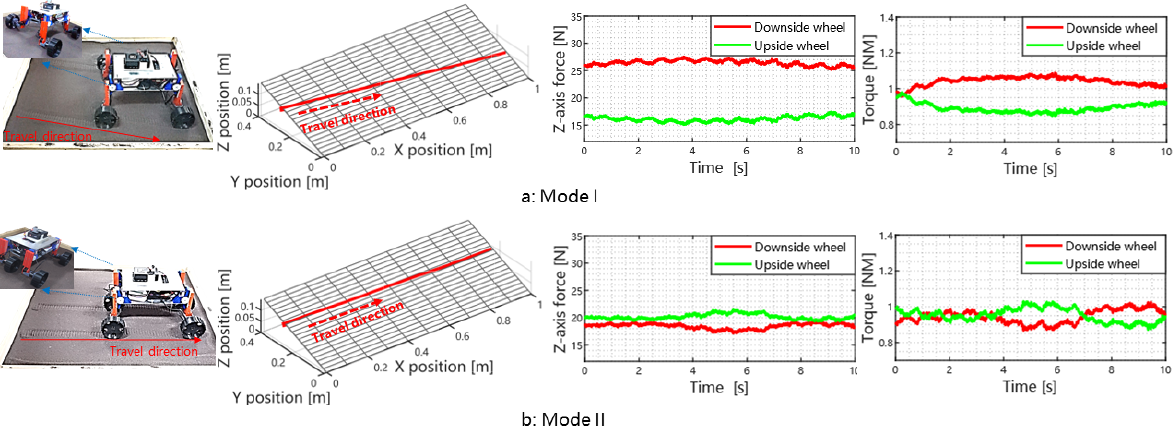
Figure 7. The rover trajectory and force/torque data were collected in the traversing task on a 20 ◦ slope. For sub-figure ( a ), the rover state is the mode I, While mode II is selected for the rover in sub-figure ( b ). The first column shows the experimental scenarios and the motion modes of ROMA- Sloper. The second column shows the trajectory of ROMA-Sloper after traversing the slope. The last two columns show the force and torque information of the wheel during the traversing